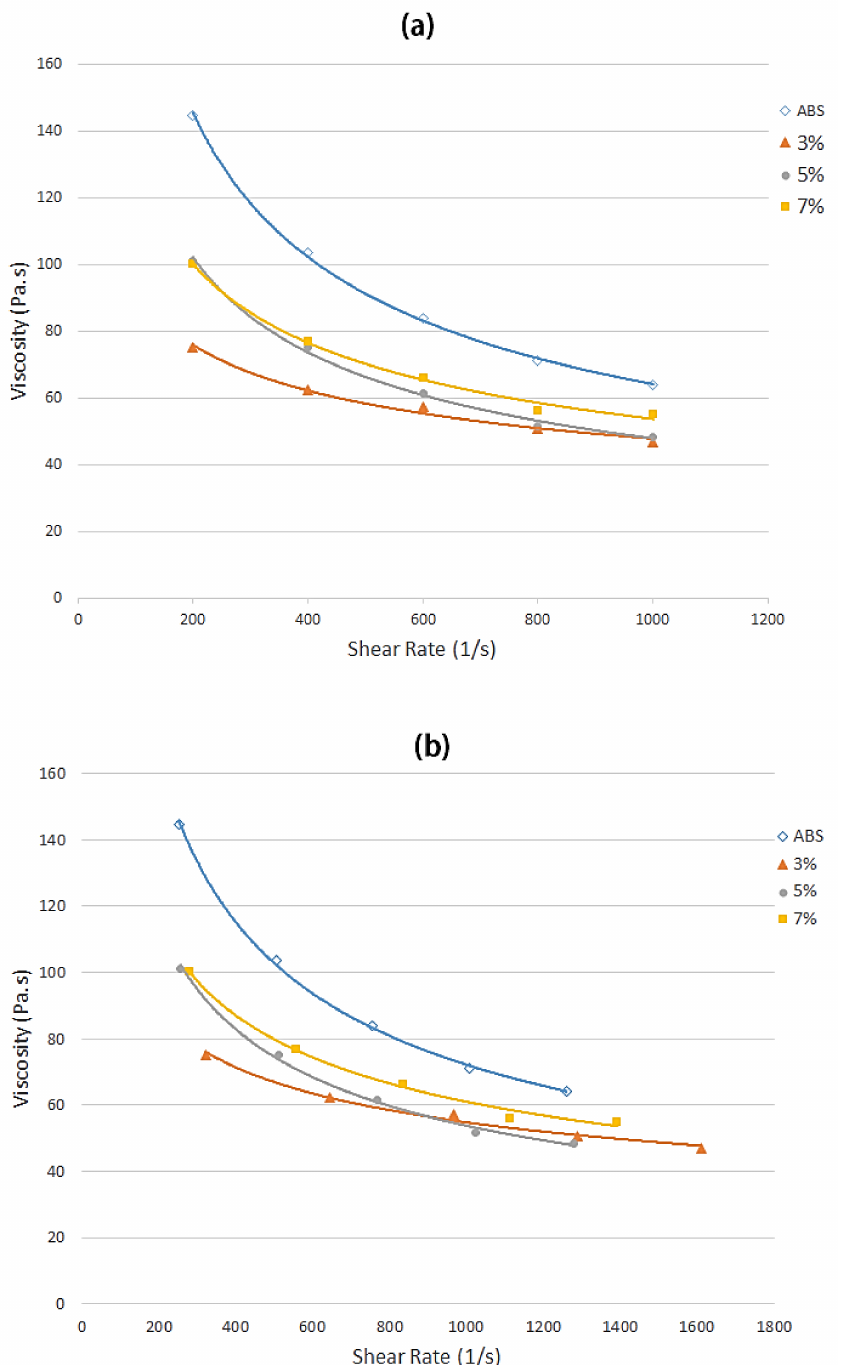
Figure 8. The apparent viscosity of the samples with oil palm fiber composite of 0, 3, 5, and 7 wt% at a 240 ◦ C die temperature: ( a ) the experimental data and ( b ) corrected factor using the Rabinowitsch